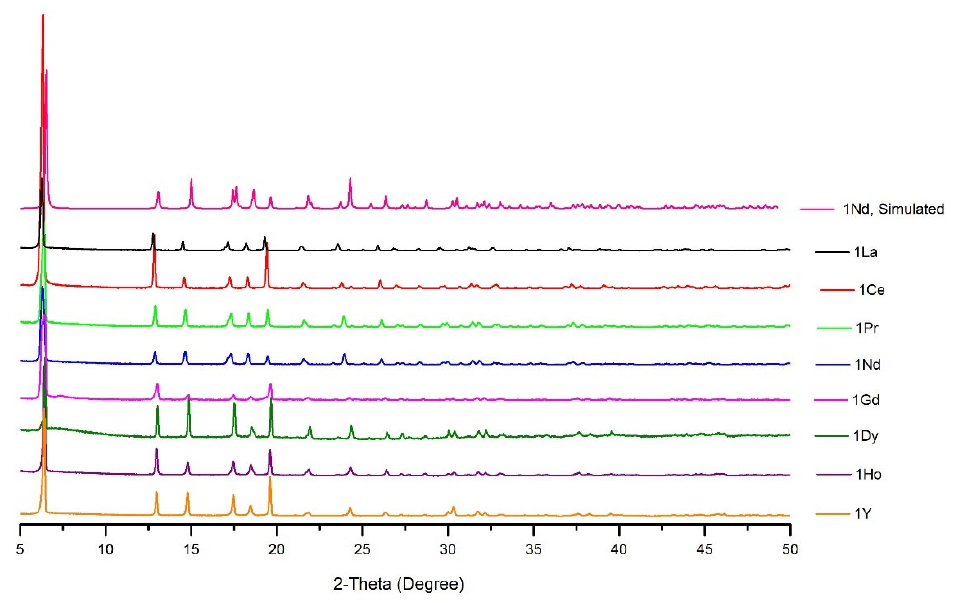
Figure 1. PXRD traces of the [RE(3fur) 3 (H 2 O) 2 ] n 1RE series compared to the simulated pattern of [Nd(3fur) 3 (H 2 O) 2 ] n ( 1Nd) .